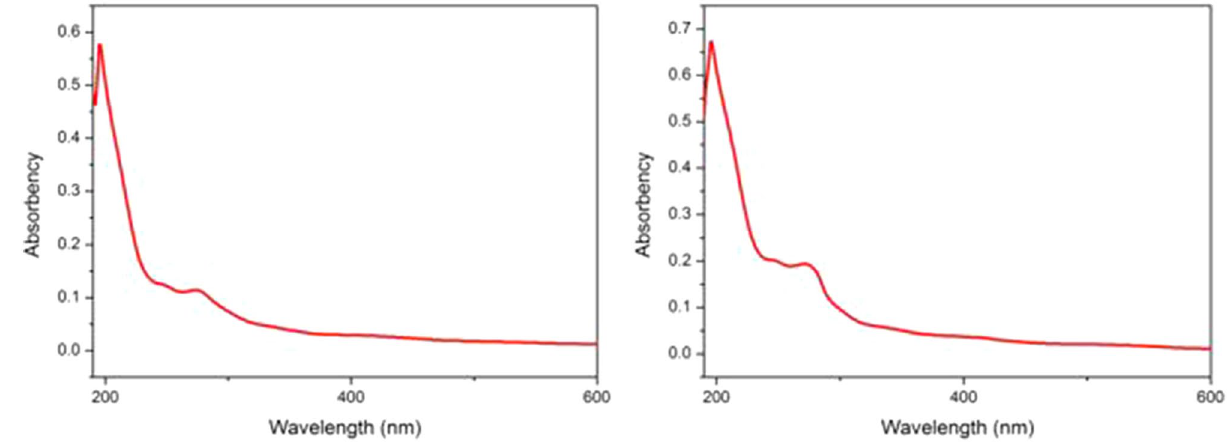
Figure 3. UV–vis spectrum of madder aqueous extraction (left) and madder ethyl alcohol extraction (right).